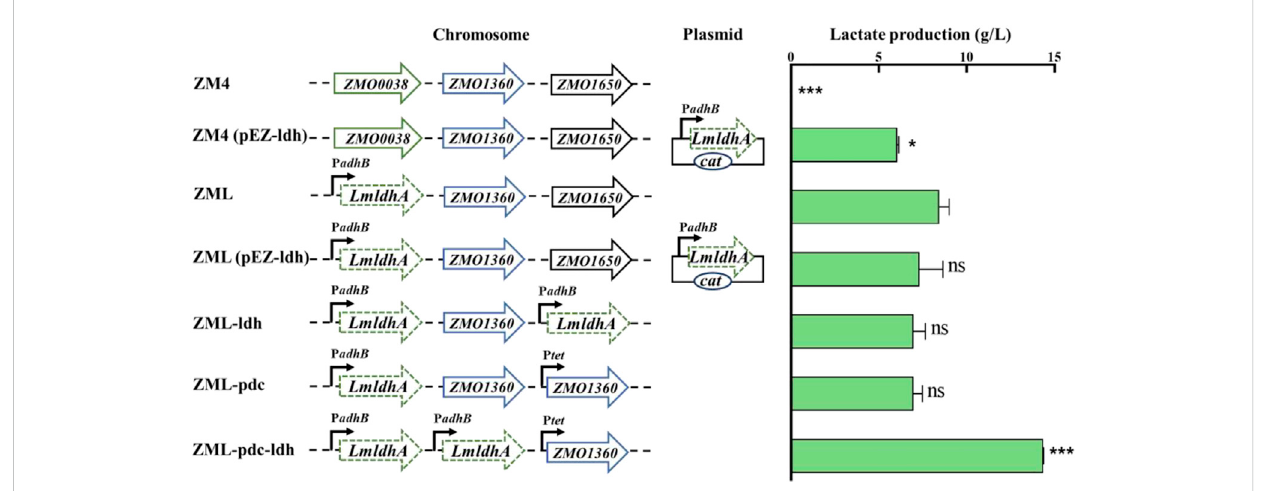
FIGURE 1 Construction and evaluation of lactate-production recombinant strains of Z. mobilis . T-test analysis was conducted for ZML with ZM4, ZM4 (pEZ- ldh), ZML (pEZ-ldh), ZML-ldh, ZML-pdc, and ZML-pdc-ldh. ns represents no signi fi cant difference ( p -value > 0.05), * represents a signi fi cant difference with p -value < 0.05. *** represents a signi fi cant difference with p -value < 0.001. Three replicates were performed for the